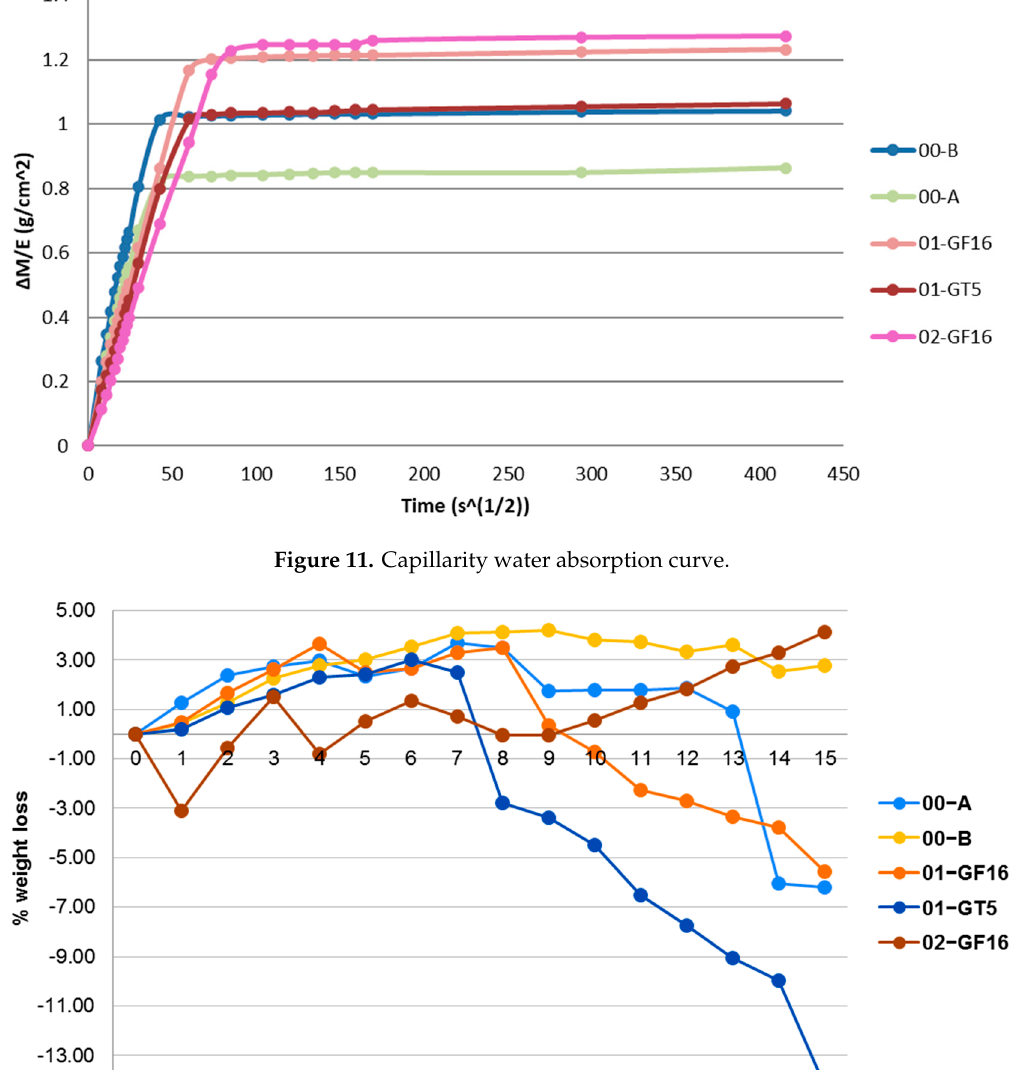
Figure 11. Capillarity water absorption curve. Table 9. Average capillarity water absorption coefficient